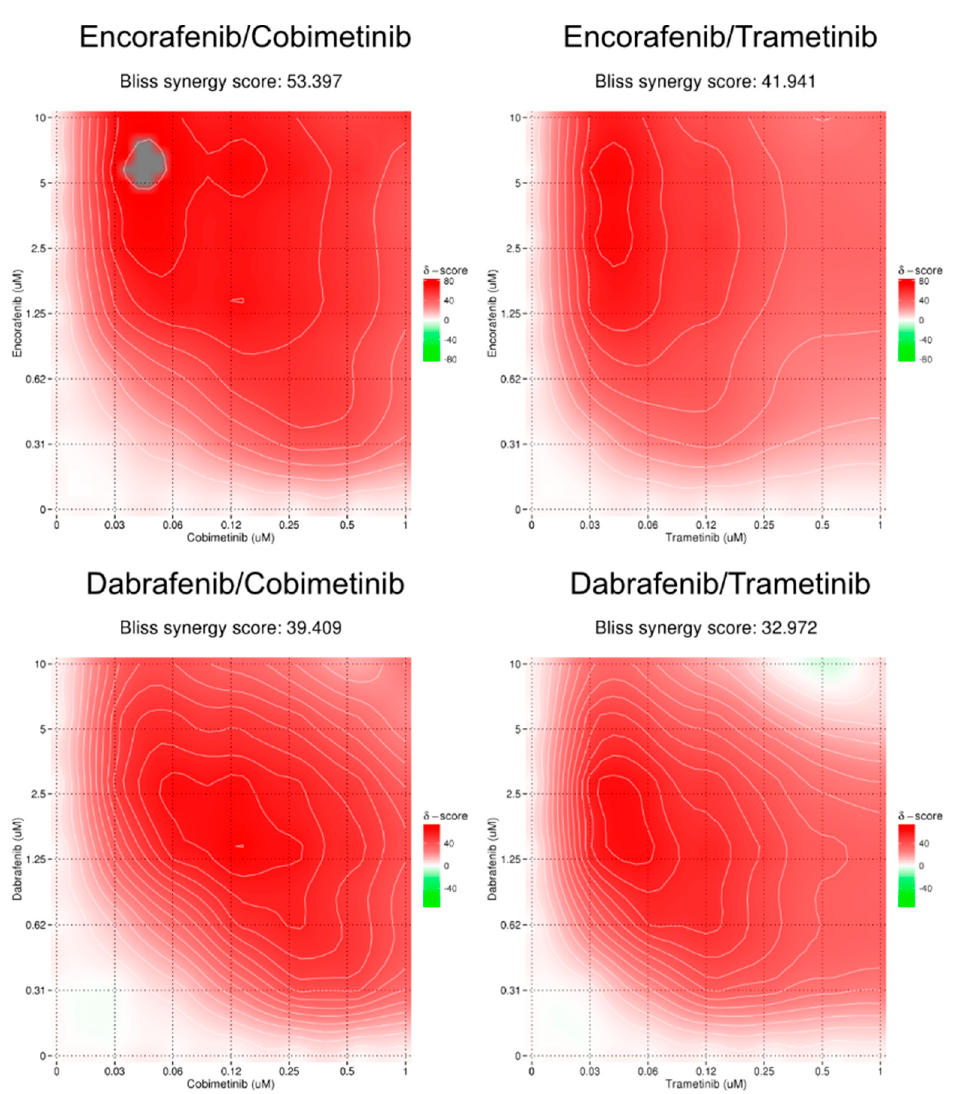
Figure 6. Synergy maps of the top four synergistic combinations in WM1366 (NRAS mut ) cell line after treatment for 72 h with single or combined BRAFi/MEKi (serial dilutions 1:2). Table 2. Comparison of synergy score and IC 50 data of the different BRAFi and MEKi combinations. BRAF mut cell lines exhibited complete resistance to final concentrations of BRAFi/MEKi after 14.6 to 30.0 months, correlating well with clinical data from patients treated with Synergy Score approved BRAFi/MEKi combinations (Table 1). As such, encorafenib plus